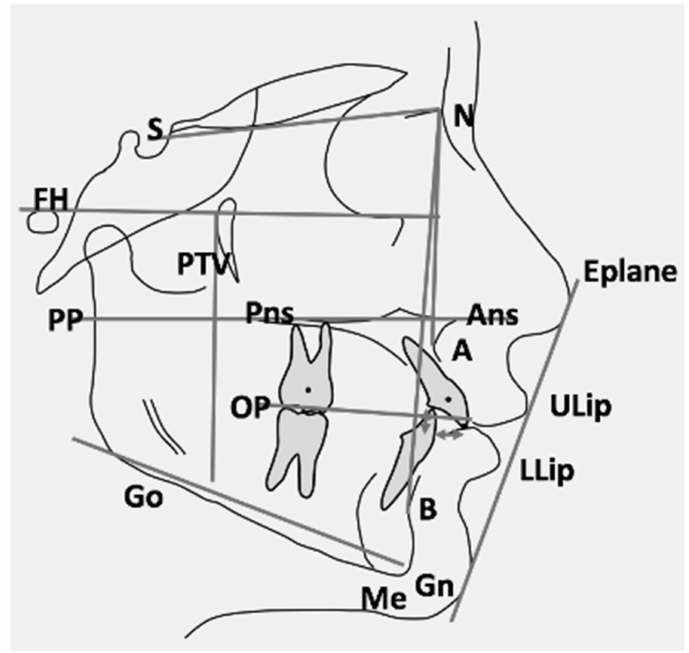
Figure 1. Graphical representation of reference points and planes used for the cephalometric analysis (S, Sella; N, Nasion; FH, Frankfurt plane; PP, palatal plane; PTV, pterygoid vertical; Pns, posterior nasal spine; Ans, anterior nasal spine; OP, occlusal plane; A, A point; B, B point; Go, Gonion; Me, Menton; Gn, Gnation; Eplane, esthetic plane; ULip, upper lip; LLip, lower